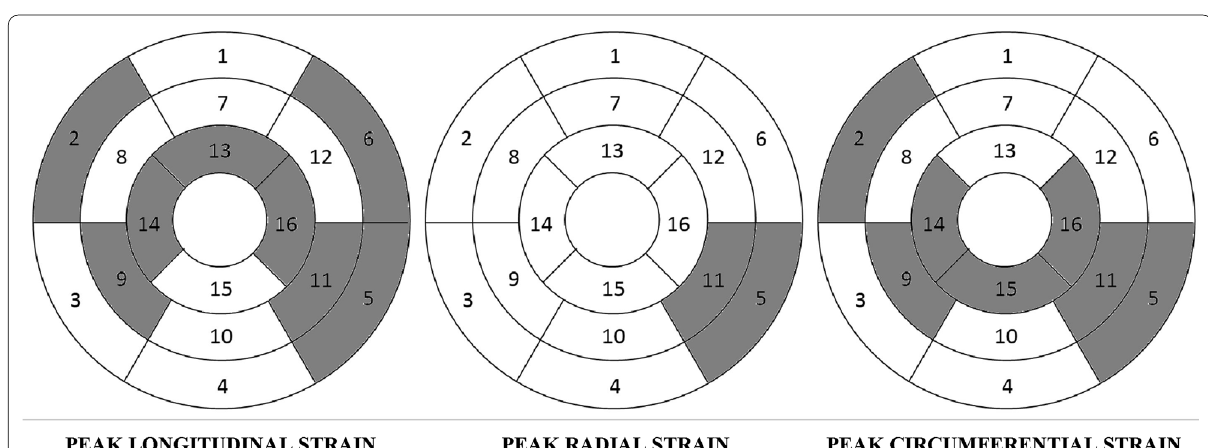
Fig. 5 Left ventricular myocardial segments with statistically significantly lower peak of strain values in the group of patients with rheumatoid arthritis compared to the control